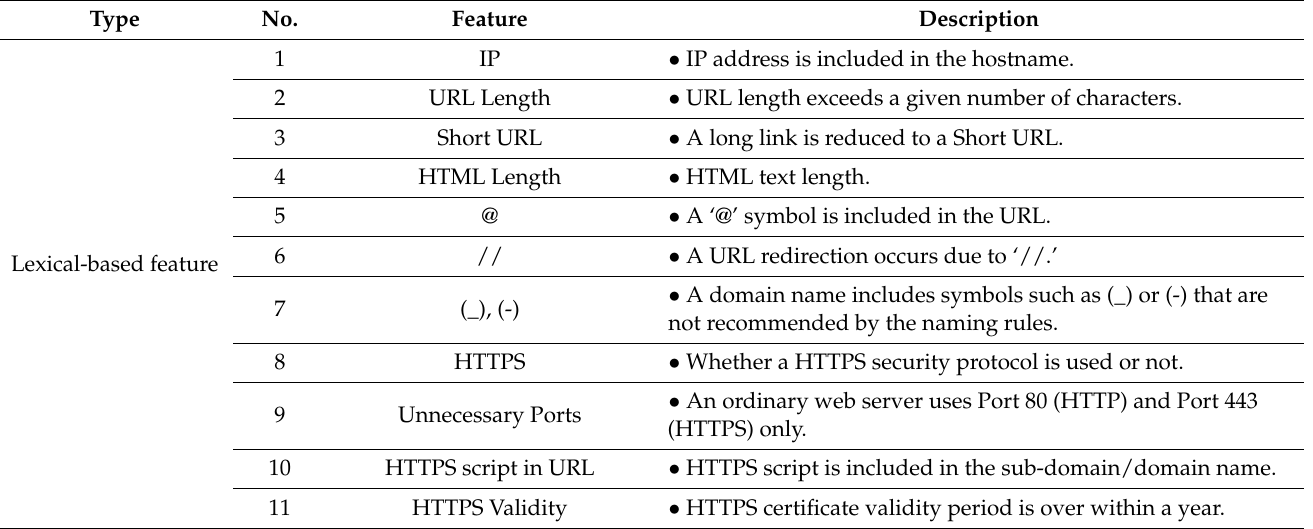
Figure 2. Malicious Web Feature Extraction Process. Table 1. Machine Learning Features for Malicious Web